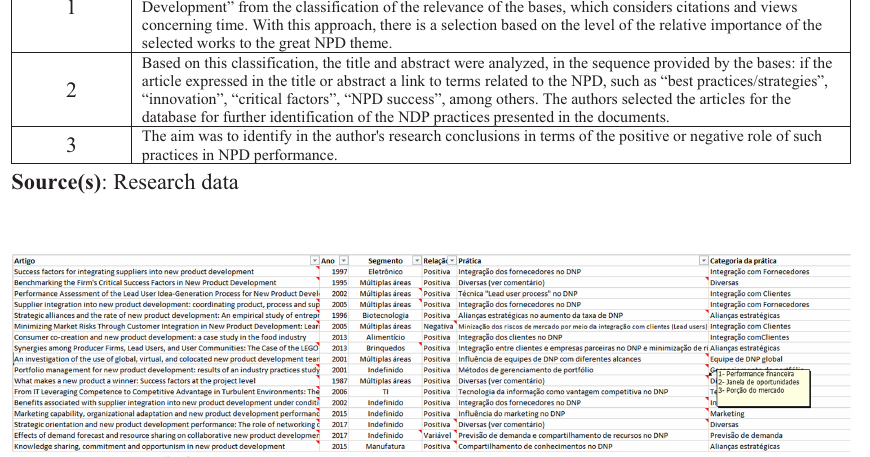
Figure 4. Categorization structure for